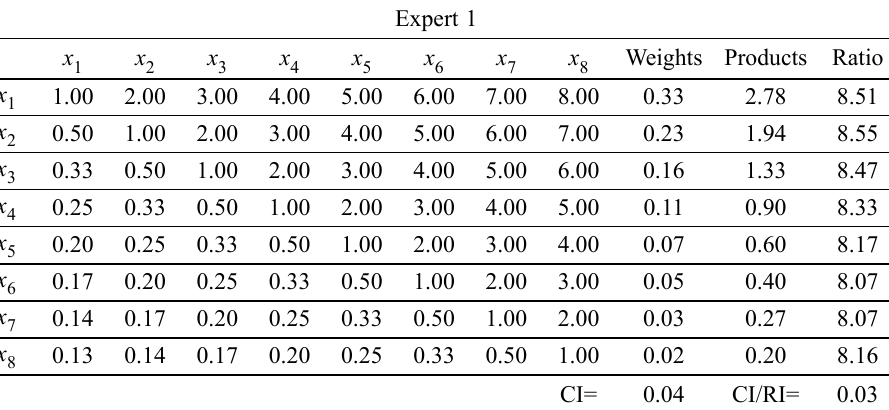
Table 2. Pairwise comparisons among